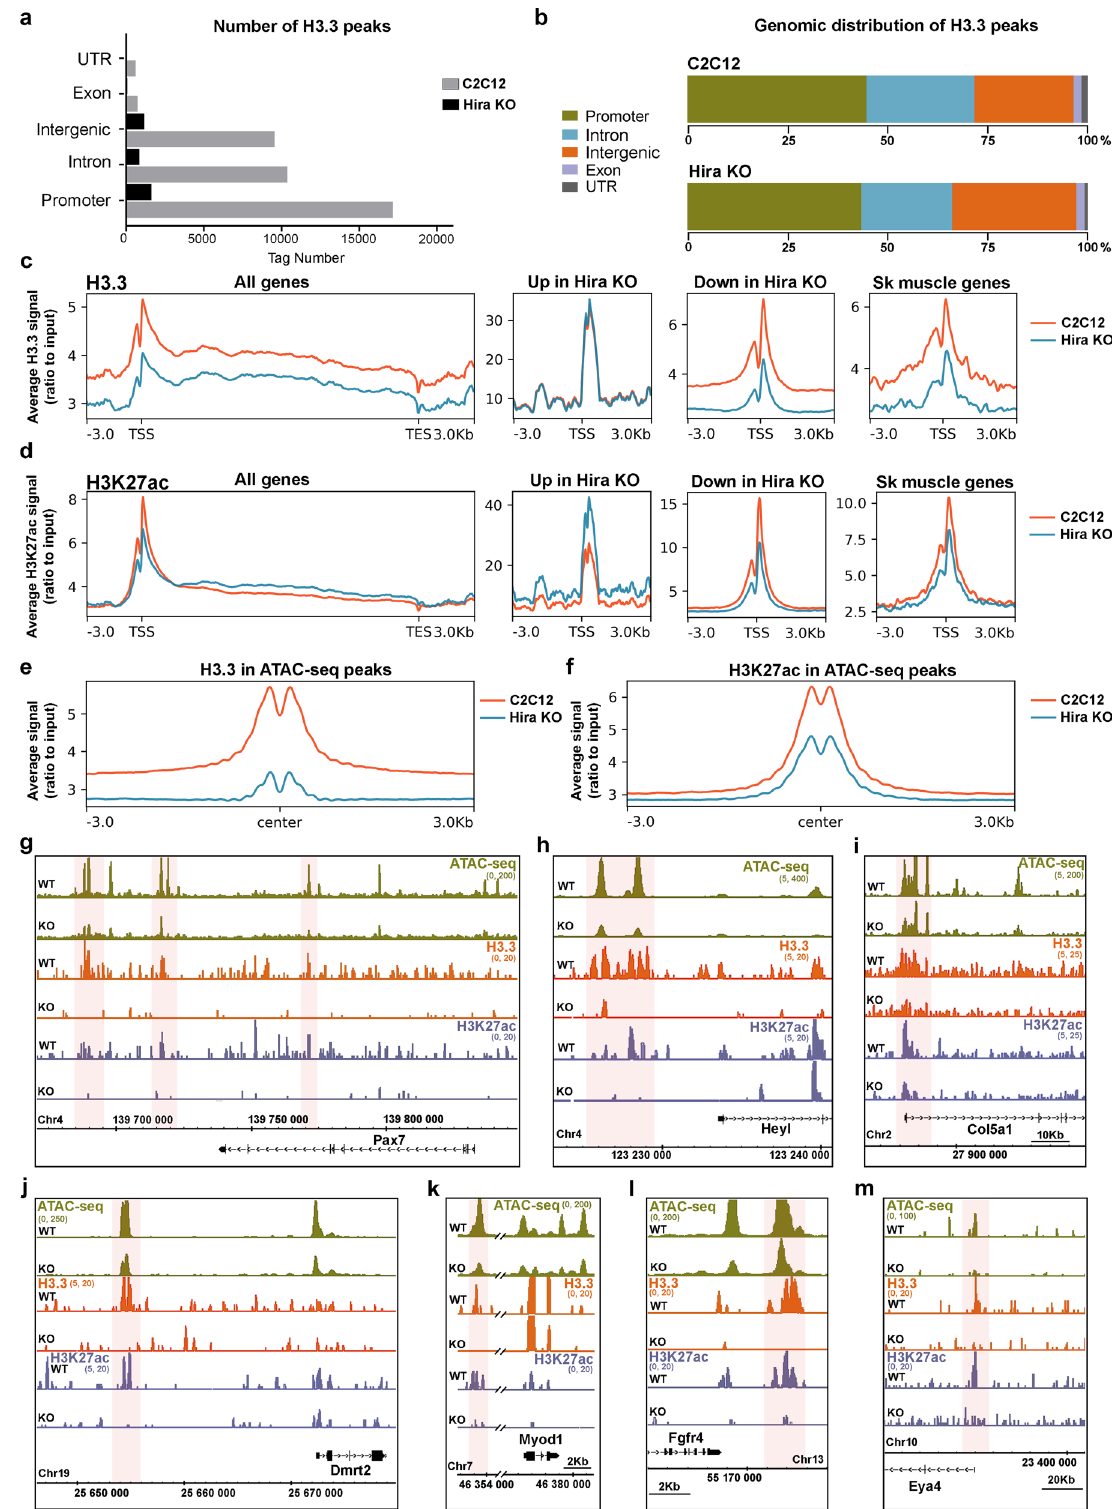
Fig. 2 Loss of H3.3 in muscle gene regulatory regions in Hira -de fi cient cells. a Total number of H3.3 called peaks (tag number) ( q - value = 5e − 2) in the ChIP-seq of C2C12 (gray, 38439 peaks) ( n = 1) and Hira -KO cells (black, 3744 peaks) ( n = 1). b Percentage of the total number of H3.3 peaks distributed in distinct genomic regions as indicated in C2C12 or Hira -KO cells. c , d ChIP-seq average signal pro fi les (ratio to input) in the promoter region (±3 kb around the TSS), TSS, gene body, and TES for H3.3 ( c ) and H3K27ac ( d ) in C2C12 (orange) and Hira KO (blue) shown for all genes, upregulated genes in Hira KO, downregulated in Hira -KO and skeletal muscle genes (GO:0007519). e , f ChIP-seq average signal pro fi les (ratio to input) of H3.3 ( e ) and H3K27ac ( f ) plotted on the control ATAC-seq peaks in C2C12 (orange) and Hira KO (blue). g – m ATAC-seq (green), ChIP-seq pro fi les for H3.3 (orange), and H3K27ac (gray) in the genomic loci of Pax7 ( g ), HeyL ( h ), Col5a1 ( i ), Dmrt2 ( j ), Myod1 ( k ), Fgfr4 ( l ), and Eya4 ( m